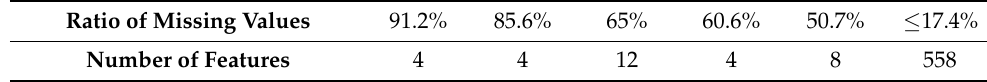
Table 3. Ratios of missing values in the dataset.